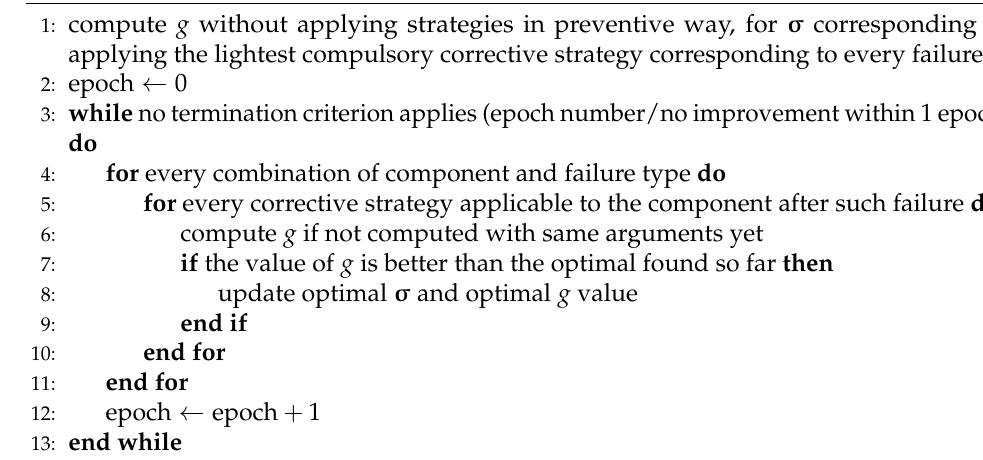
Algorithm 1 Algorithm for pre-optimization for corrective strategies